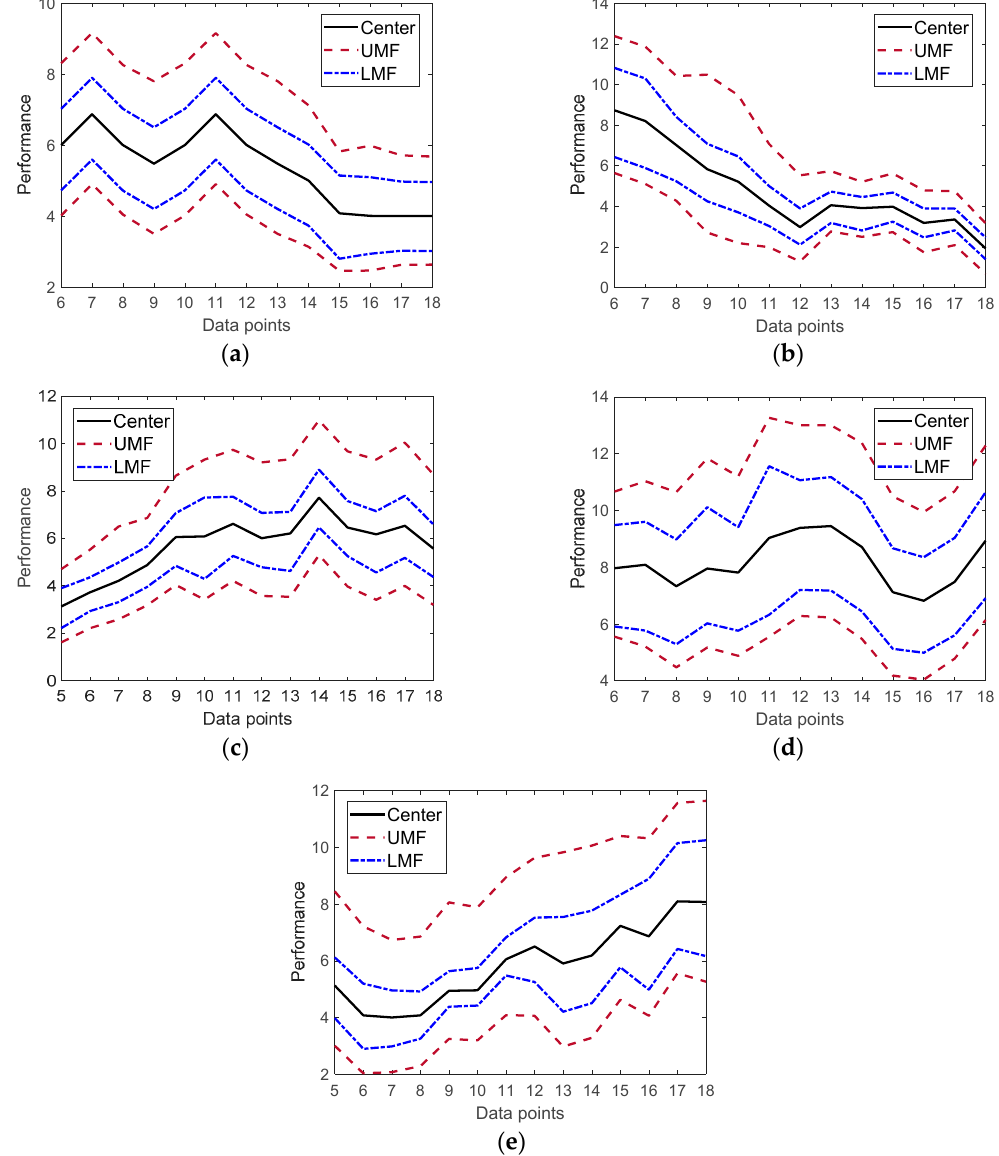
Figure 6. Estimations for the 1st alternative. ( a ) 1st criterion; ( b ) 2nd criterion; ( c ) 3rd criterion; ( d ) 4th criterion and ( e ) 5th criterion.